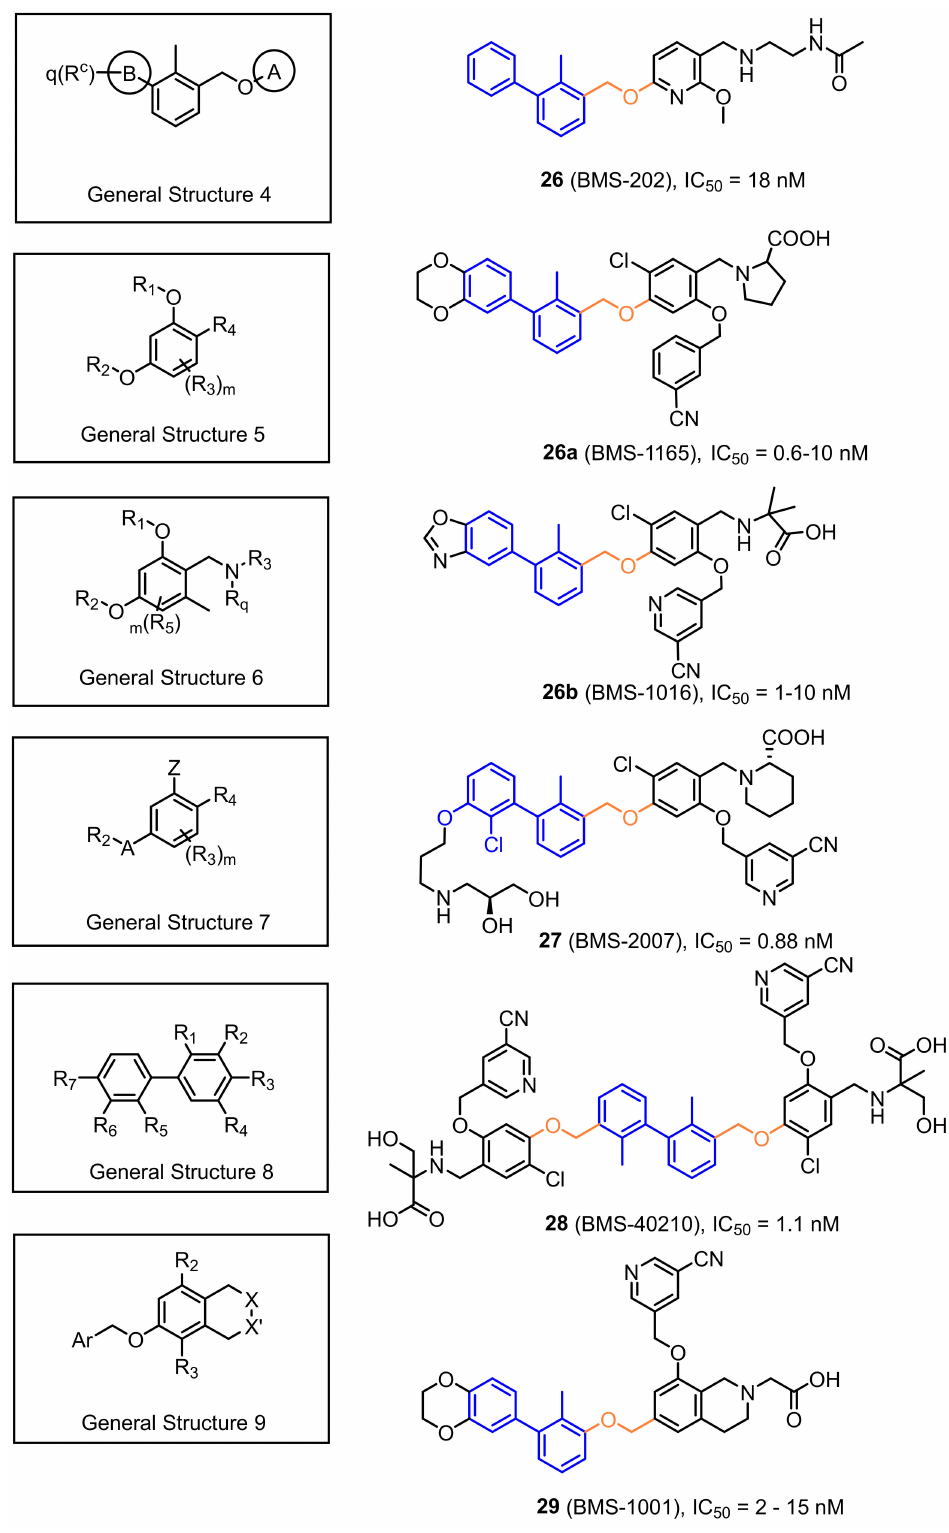
Figure 13. General structures of the compounds disclosed by Bristol-Myers Squibb company and their representative examples